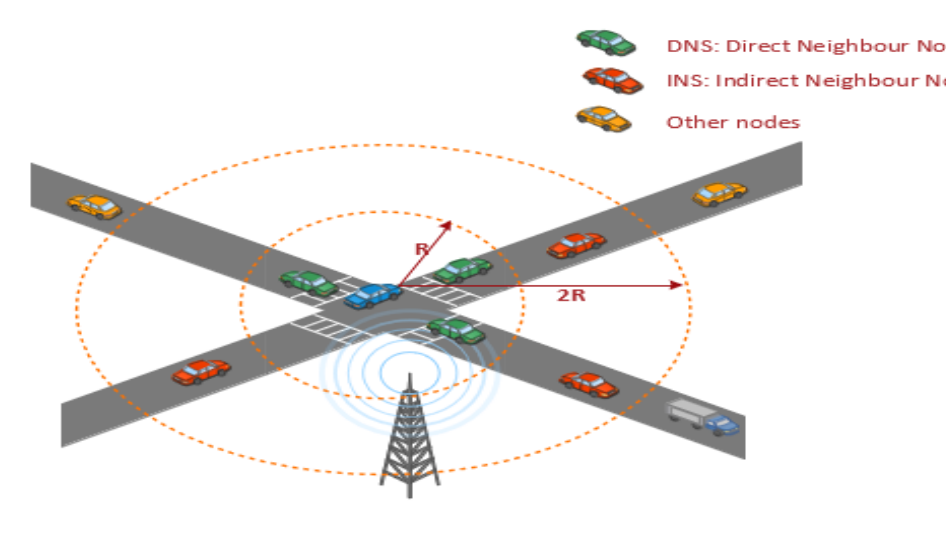
Figure 7. Mechanism of TCG MAC